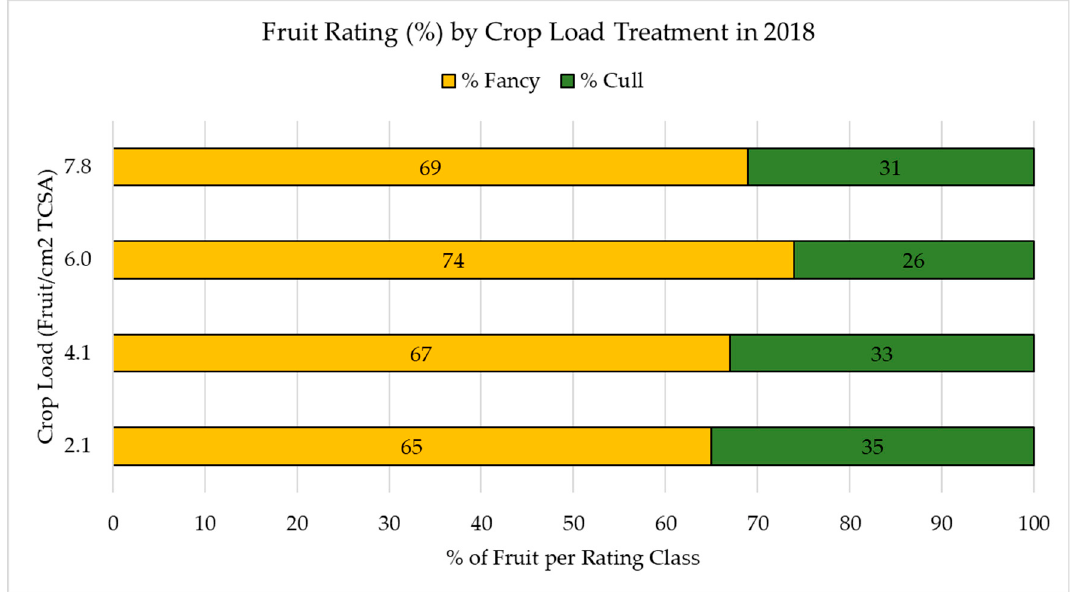
Figure 5. Fruit class rankings (fancy and cull) for “WA38” fruit harvested in the fall of 2018 in Washington State, Wenatchee area, across each crop load (2.1, 4.1, 6.0, 7.8 fruits/cm 2 ) category that was set in 2017. All fruits per trial tree were rated immediately after harvest on 21 September 2018. Fancy and extra fancy rankings were combined due to a minimal number of extra fancy fruit. Crop loads were not induced in 2018; this was the natural bearing tendency after crop load was induced in 2017.